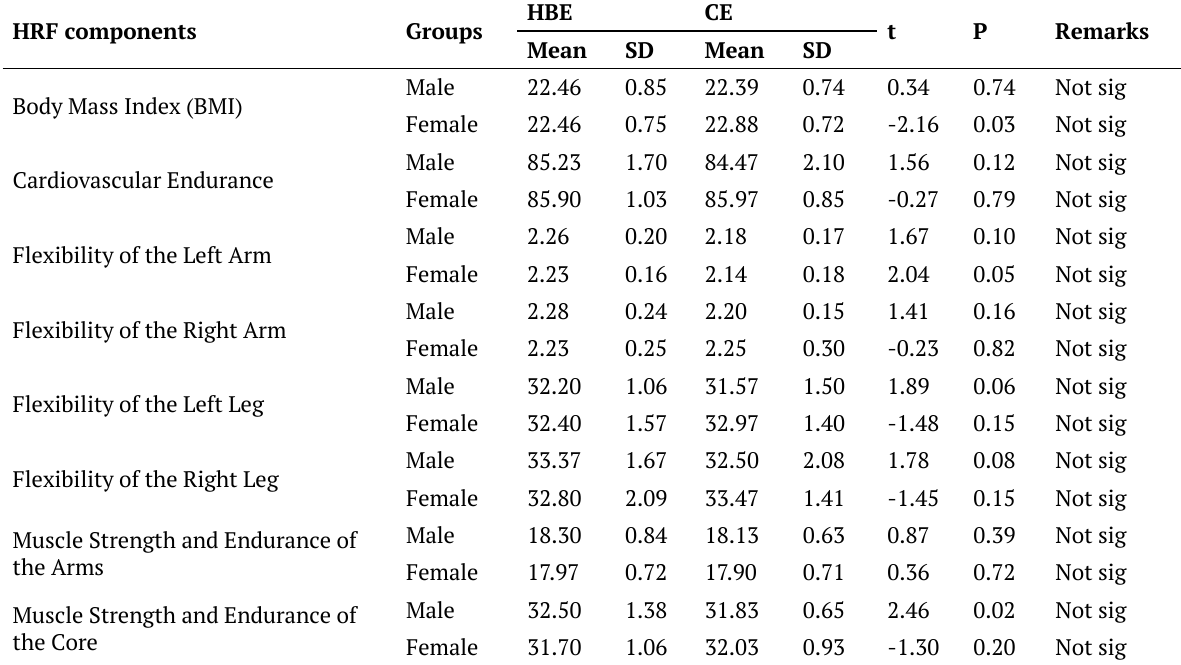
Table 1. Significant difference of the Pre-test scores of participants (male vs. male, female vs. female) in the HBE and CE